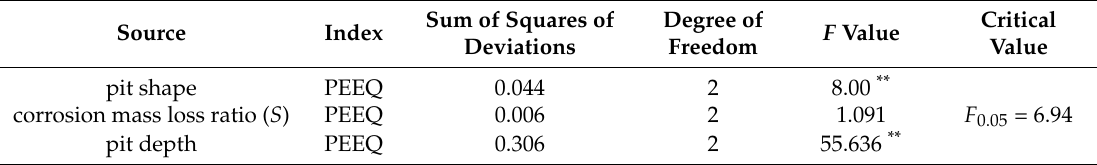
Table 7. Analysis of variance.